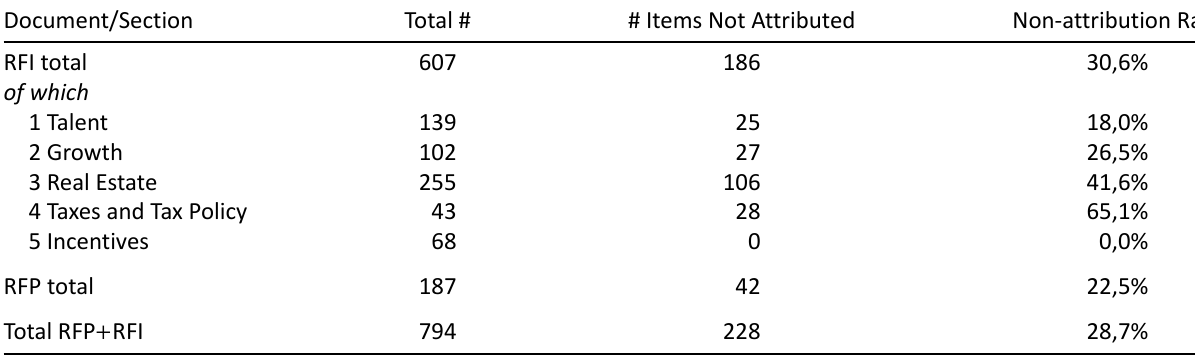
Figure 8. Attribution rate of different approaches. Table 3. Non-attribution rates by document and